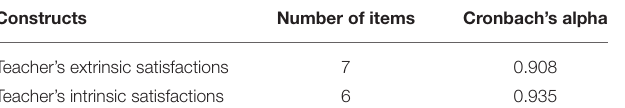
TABLE 2 | Reliability analysis.